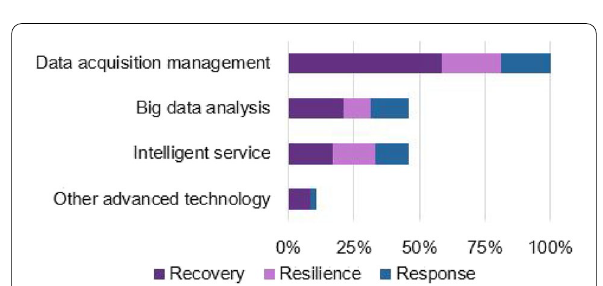
Figure 3 A technological histogram for industrial cases of